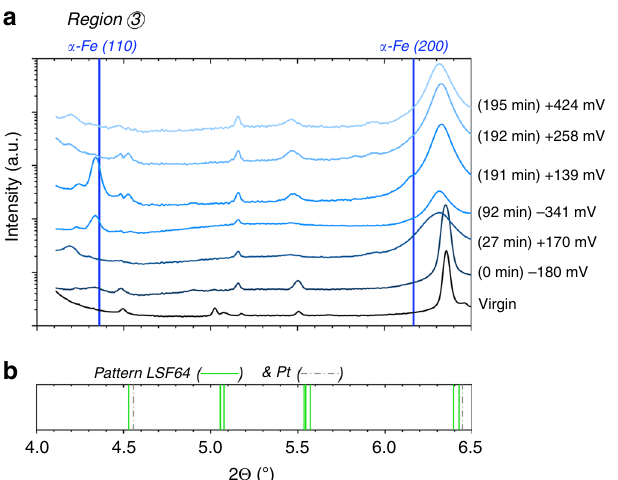
Fig. 4 1D diffraction pattern obtained by integration within region 3 of the 2D patterns in Fig. 2b and Supplementary Fig. 4. a The shown 2 Θ part focuses on the region of possible re fl exes of metallic iron. The blue vertical lines indicate the two expected re fl exes of bcc iron ( α -Fe, pdf# 04-014- 0360) 31 , which is the thermodynamically stable Fe modi fi cation at the experimental temperature. Please note that the scale of the intensity axis is logarithmic. b Literature pattern of rhombohedral La 0.6 Sr 0.4 FeO 3- δ . (pdf# 00-049-0285) and platinum (pdf# 00-004-0802) 31 .